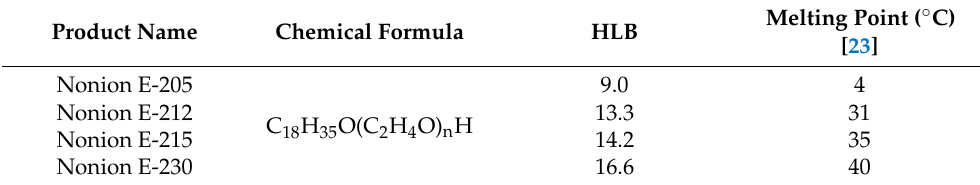
Table 1. The hydrophobic-lipophilic-balance (HLB) and melting point of surfactants. Product